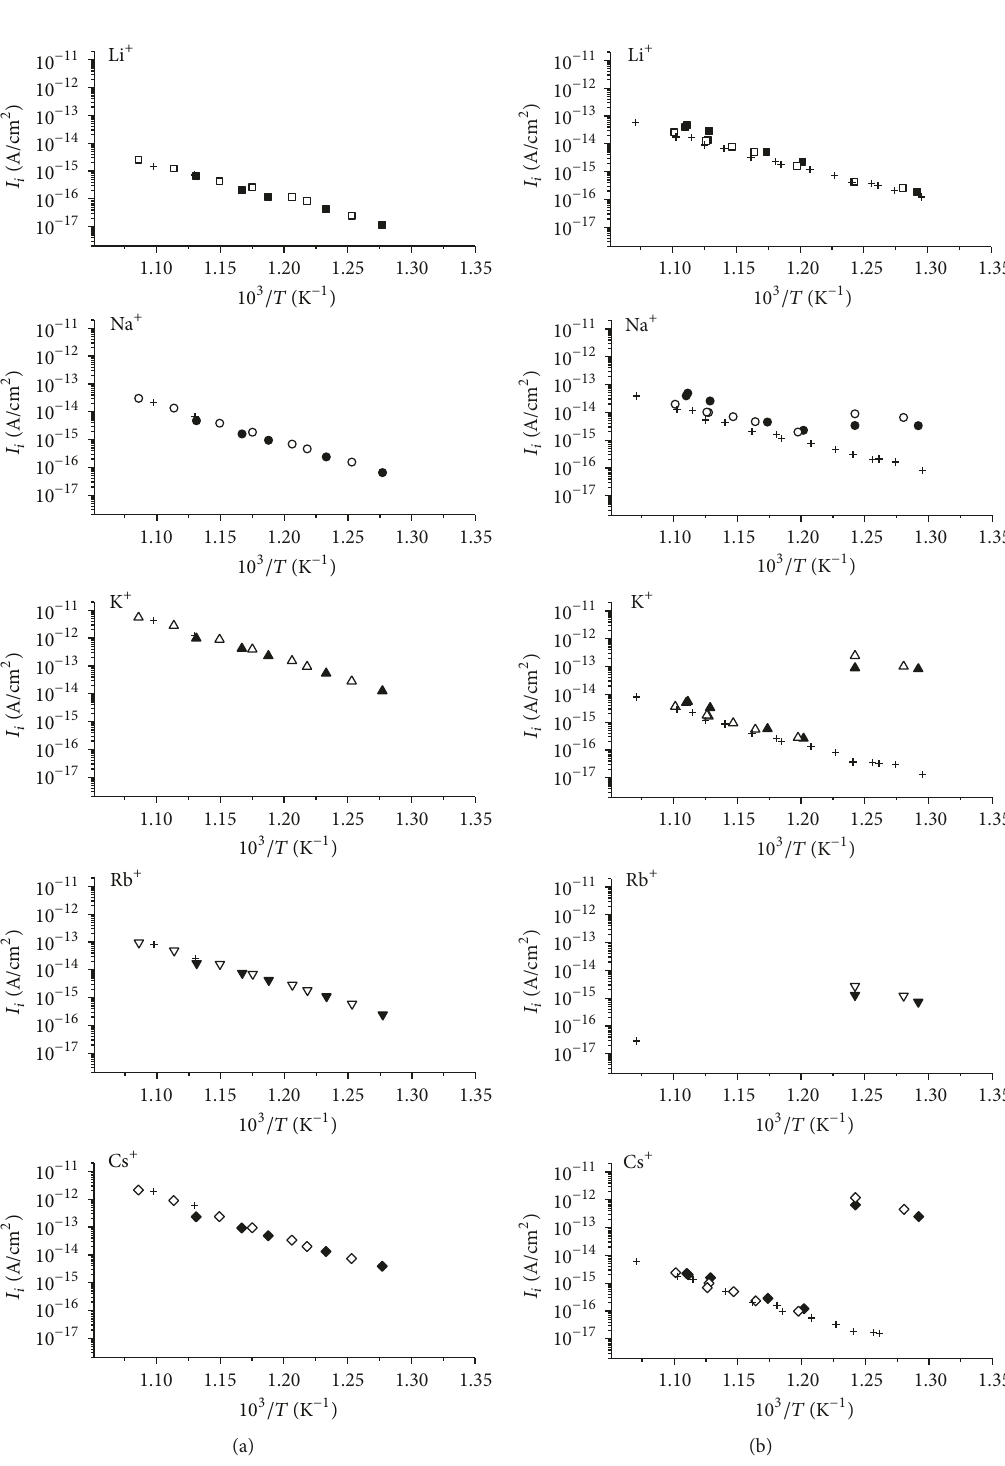
Figure 2: Temperature dependence of thermal emission ion currents measured for samples of natural MM (a) and Al 30 -pillared MM (b); open and solid symbols correspond to the first cooling and heating; crosses relate to repeated cooling and